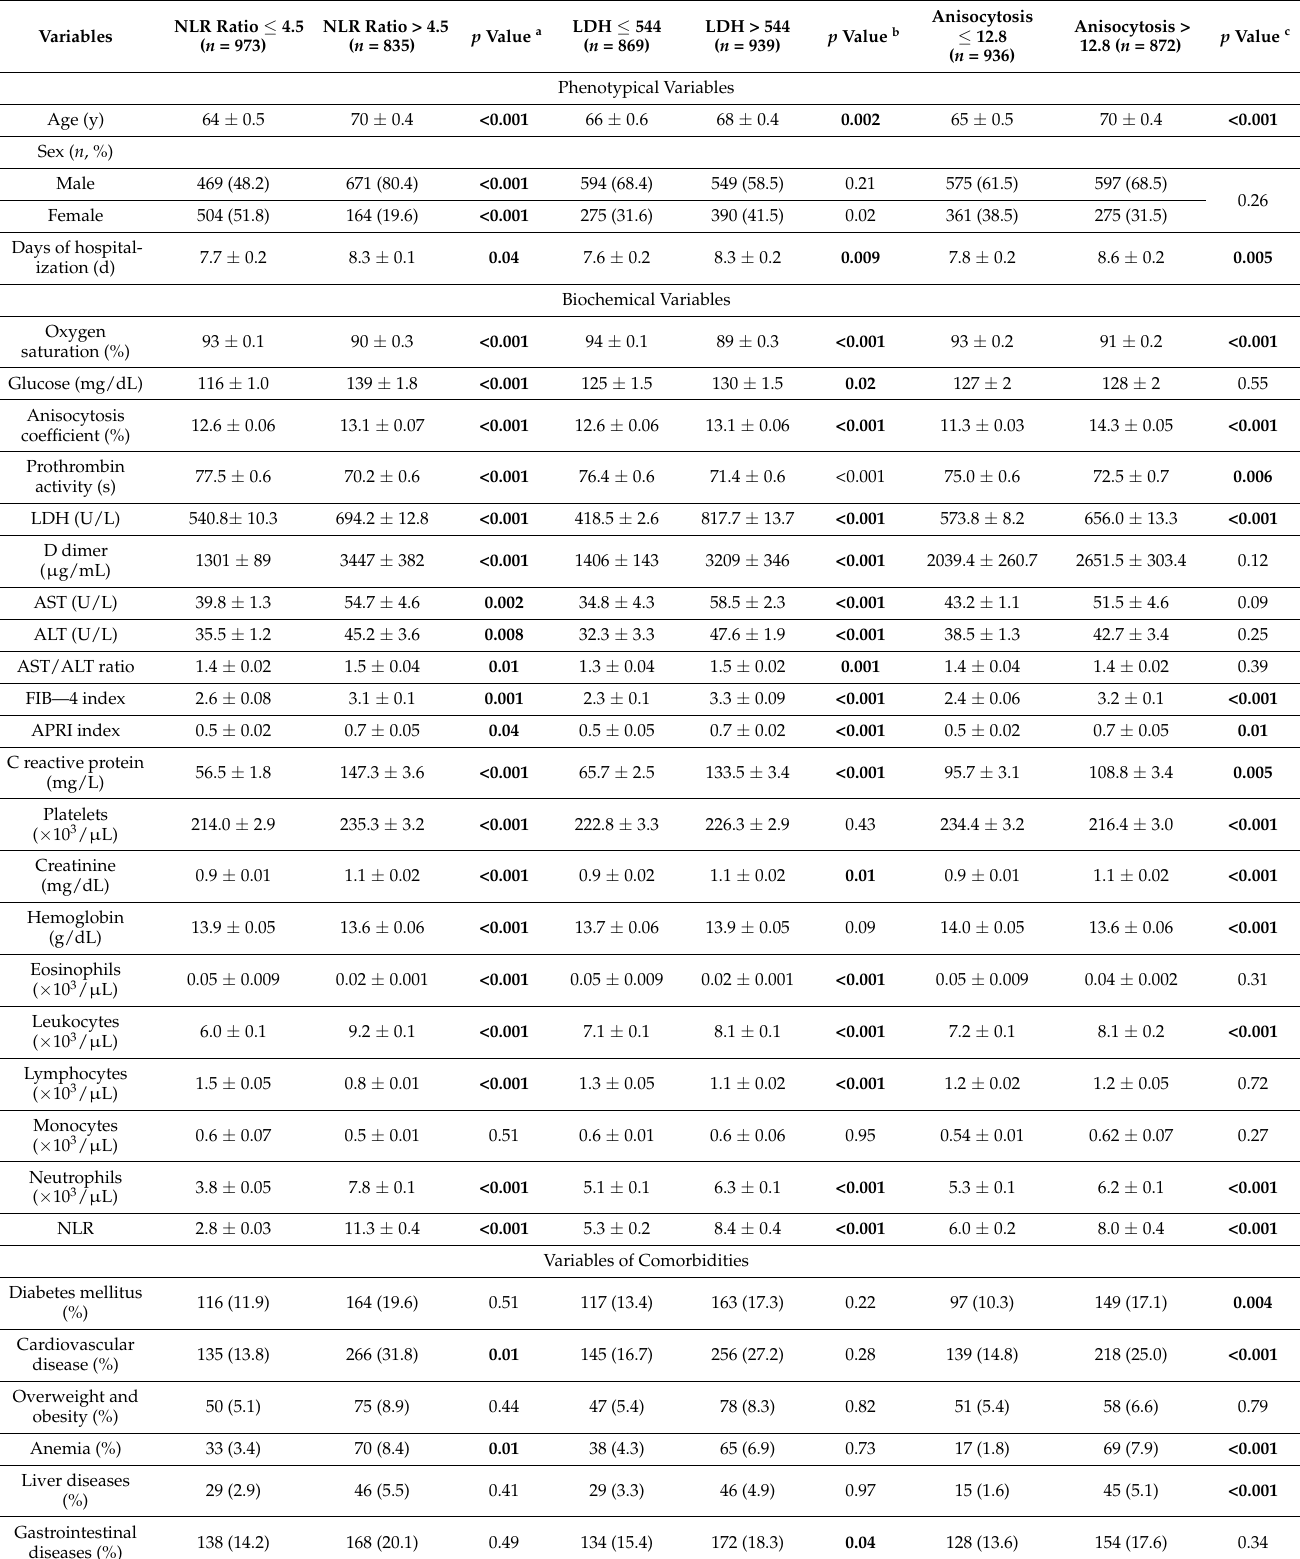
Table 4. Comparison of clinical and phenotypical variables of COVID-19 infected patients according to inflammatory (NLR and anisocytosis) and oxidative stress